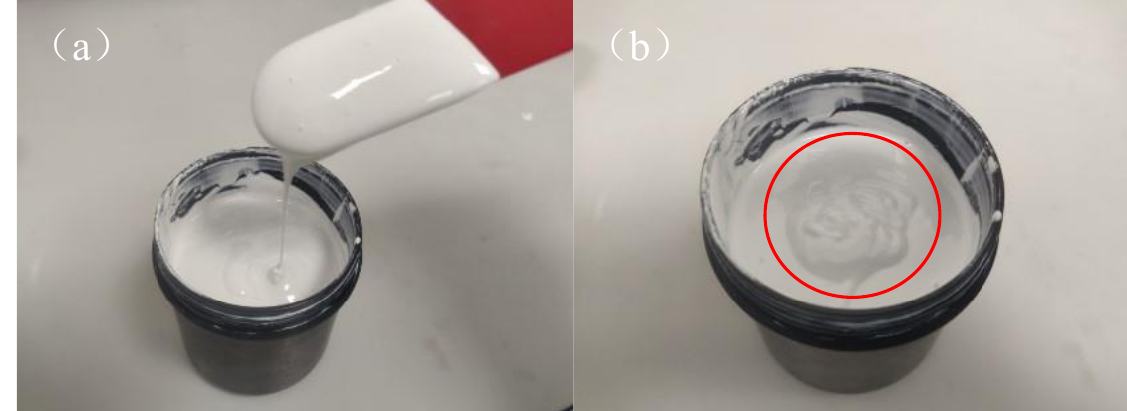
Figure 2. Ceramic slurry with gel behavior in ( a ) flow state, ( b ) static state.